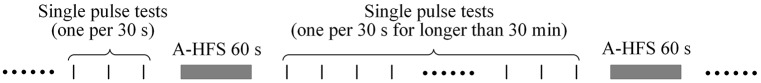
Schematic timeline of stimulation paradigms. The idle intervals between sequential A-HFS sequences were longer than 30 min to ensure recovery from the previous stimulation. Single pulse tests (one per 30 s) were run in the intervals to monitor the changes of evoked APS.